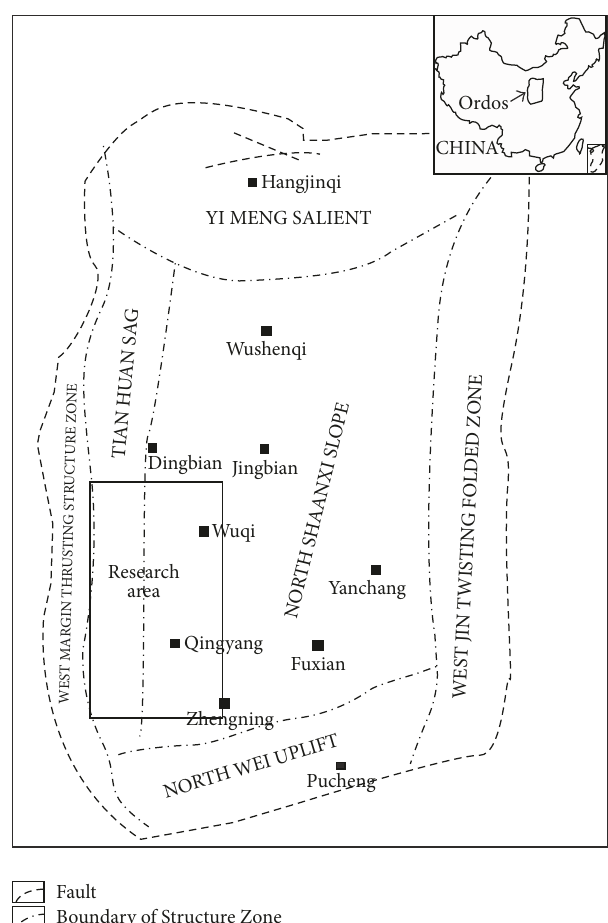
Figure 1: The location of research area and the Ordos